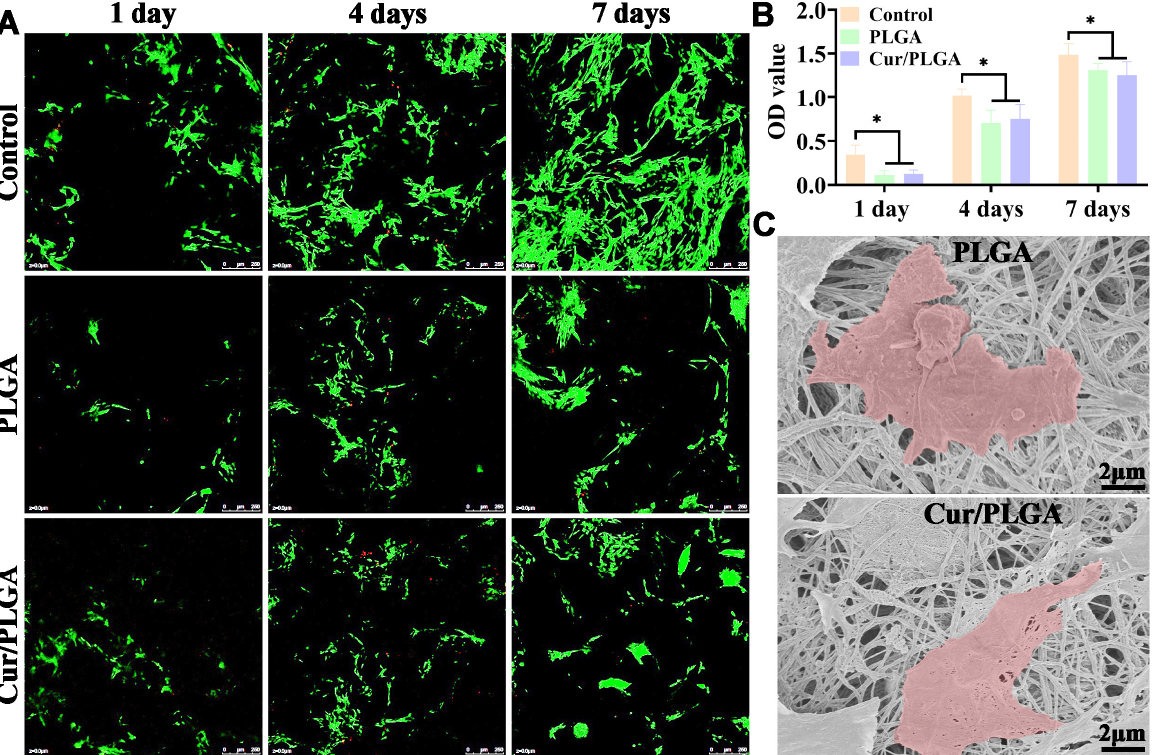
Figure 2. In vitro cytocompatibility of the curcumin/poly(lactic-co-glycolic acid) (Cur/PLGA) nanofibrous membrane: Live/dead staining ( A ) and optical density (OD) values, which were determined using the cell counting kit (CCK)-8 assay ( B ), of chondrocytes seeded onto the Petri dish (control), PLGA, and Cur/PLGA nanofibrous membranes for 1–7 days. Scanning electron micros- copy analysis of RAW264.7 macrophages seeded onto the PLGA and Cur/PLGA nanofibrous membranes for 24 h ( C ). The red color indicates the RAW264.7 macrophages. * p < 0.05.